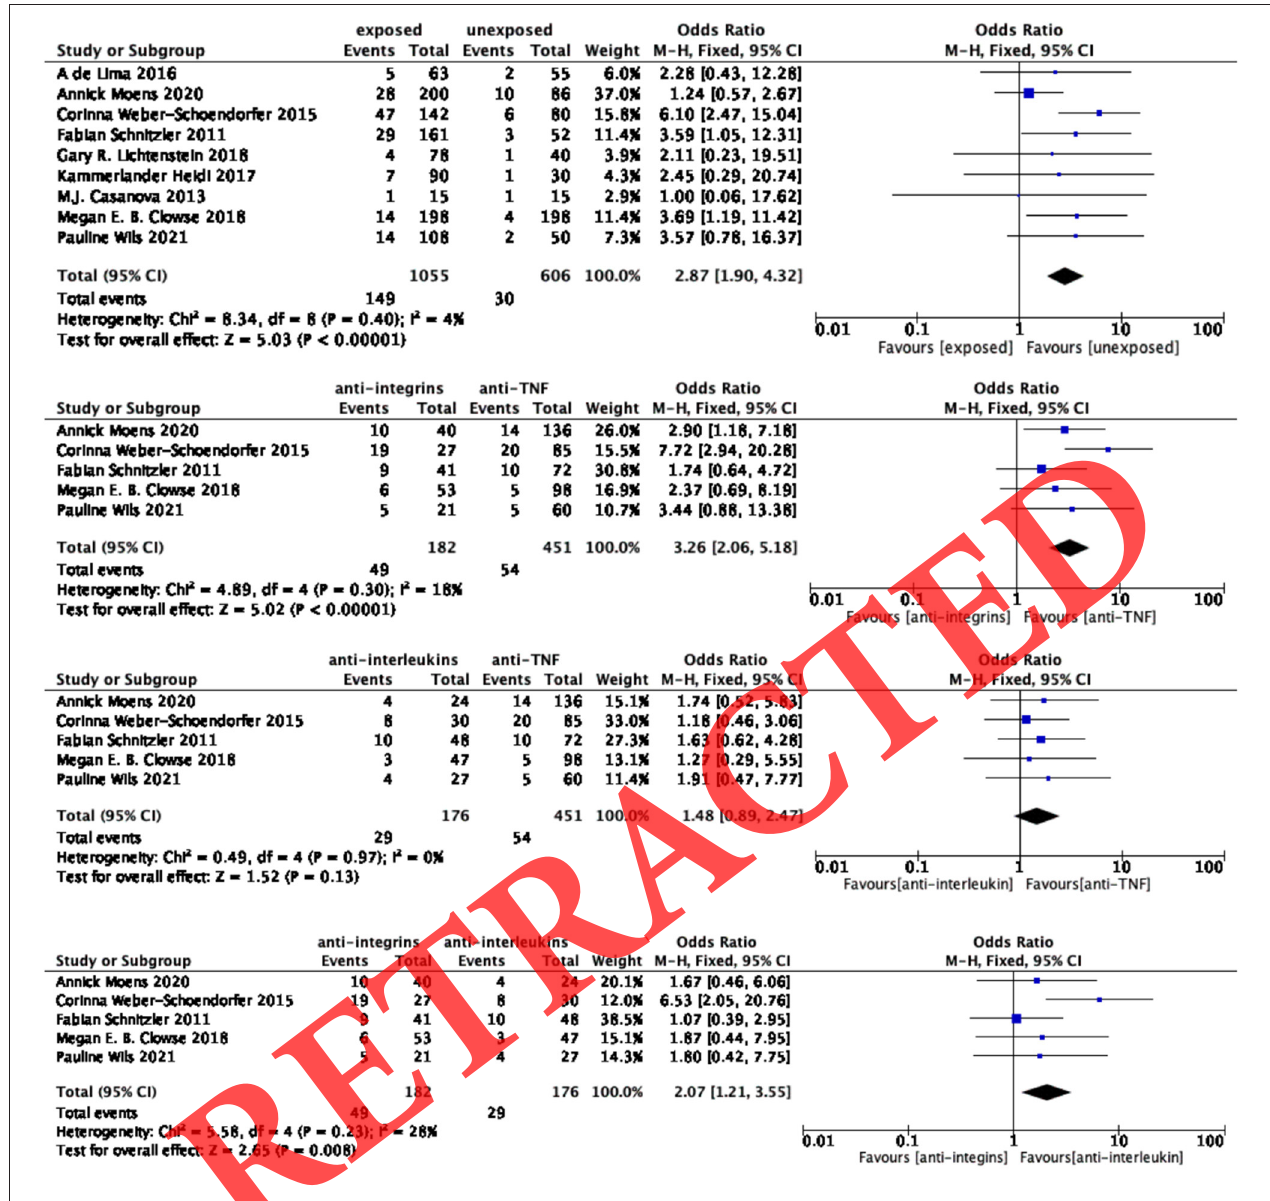
FIGURE 2 | Risk of preterm delivery in pregnant women treated with biologics for